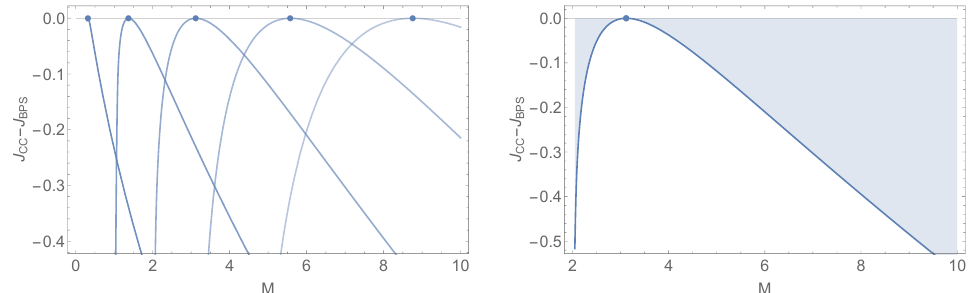
Figure 6. (Left) The di(cid:11)erence between the BPS and cosmic censorship bound for four-dimensional Einstein-Maxwell-AdS. Curves correspond to (cid:12)xed Q = : 3 ; : 9 ; 1 : 5 ; 2 : 1 ; 2 : 7 (left to right, darker to lighter). Circles indicate locations where extremal black holes satisfy the BPS condition M = j J j + Q and BPS states are otherwise superextremal. (Right) The Q = 1 : 5 curve. Shaded region corresponds to CFT states with superextremal bulk duals that are not excluded by our bound. The feature J BPS > J CC is true except at isolated points where J BPS = J CC . This is characteristic of charged, spinning solutions in d = 3 ; 4 with at least one spin and d = 5 ; 6 with at least two spins. Without both charge and spin the inequality is never